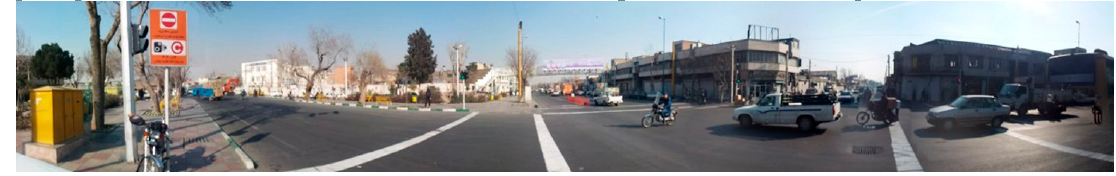
Figure 10. Panorama taken at the intersection of Harandi Street and Shush Street (point No. 1).